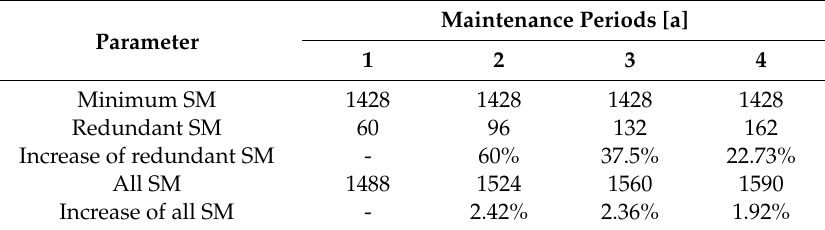
Table 2. Number of redundant SMs for di ff erent maintenance